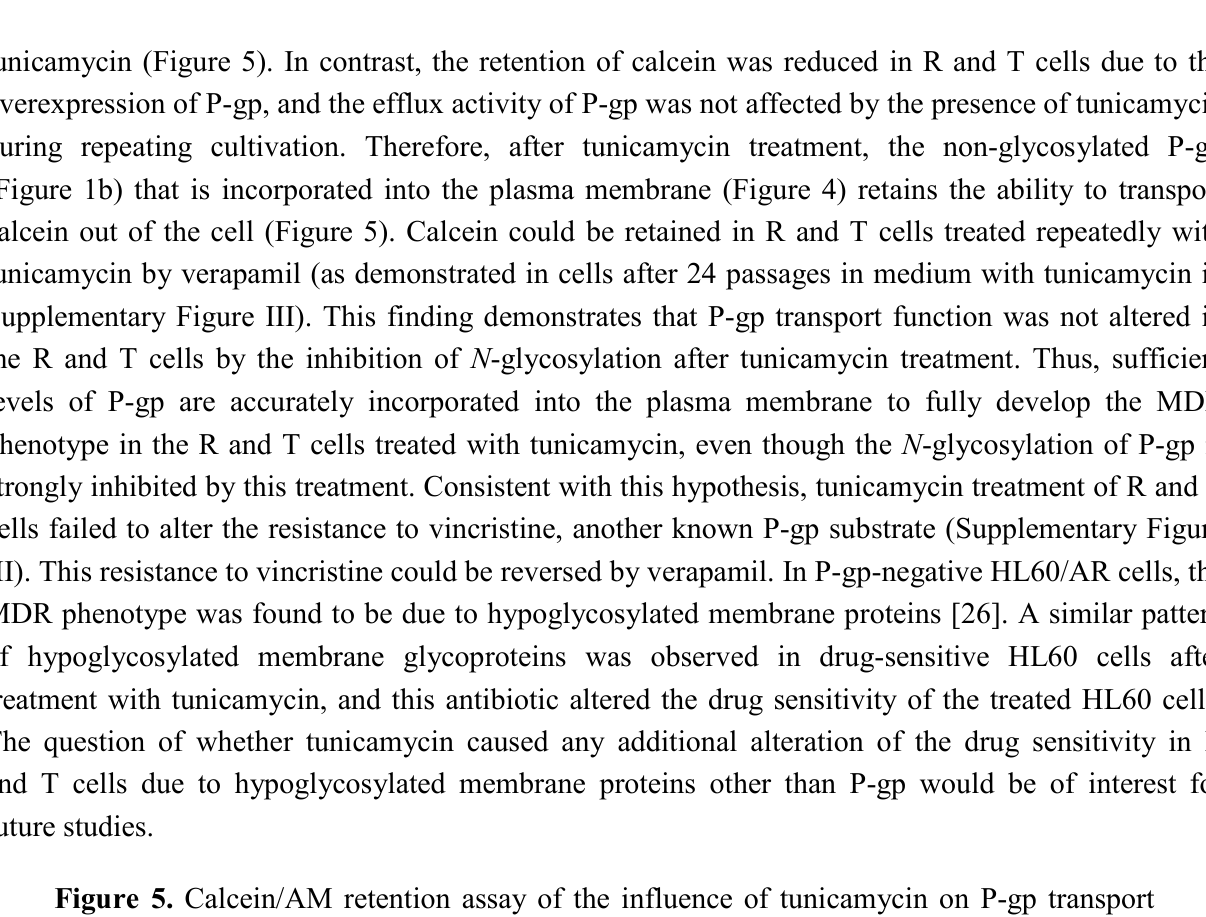
) or the presence of one 0 ) of 0.1 μmol/L tunicamycin 24